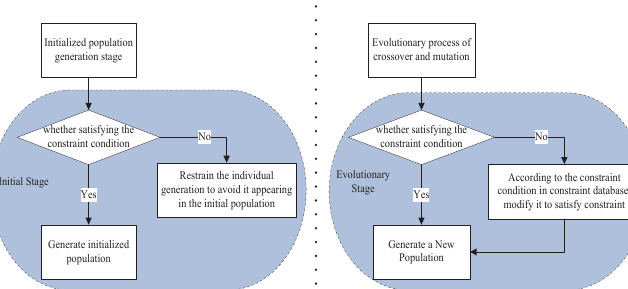
Fig.3. Treatment of individual dissatisfying constraint in different